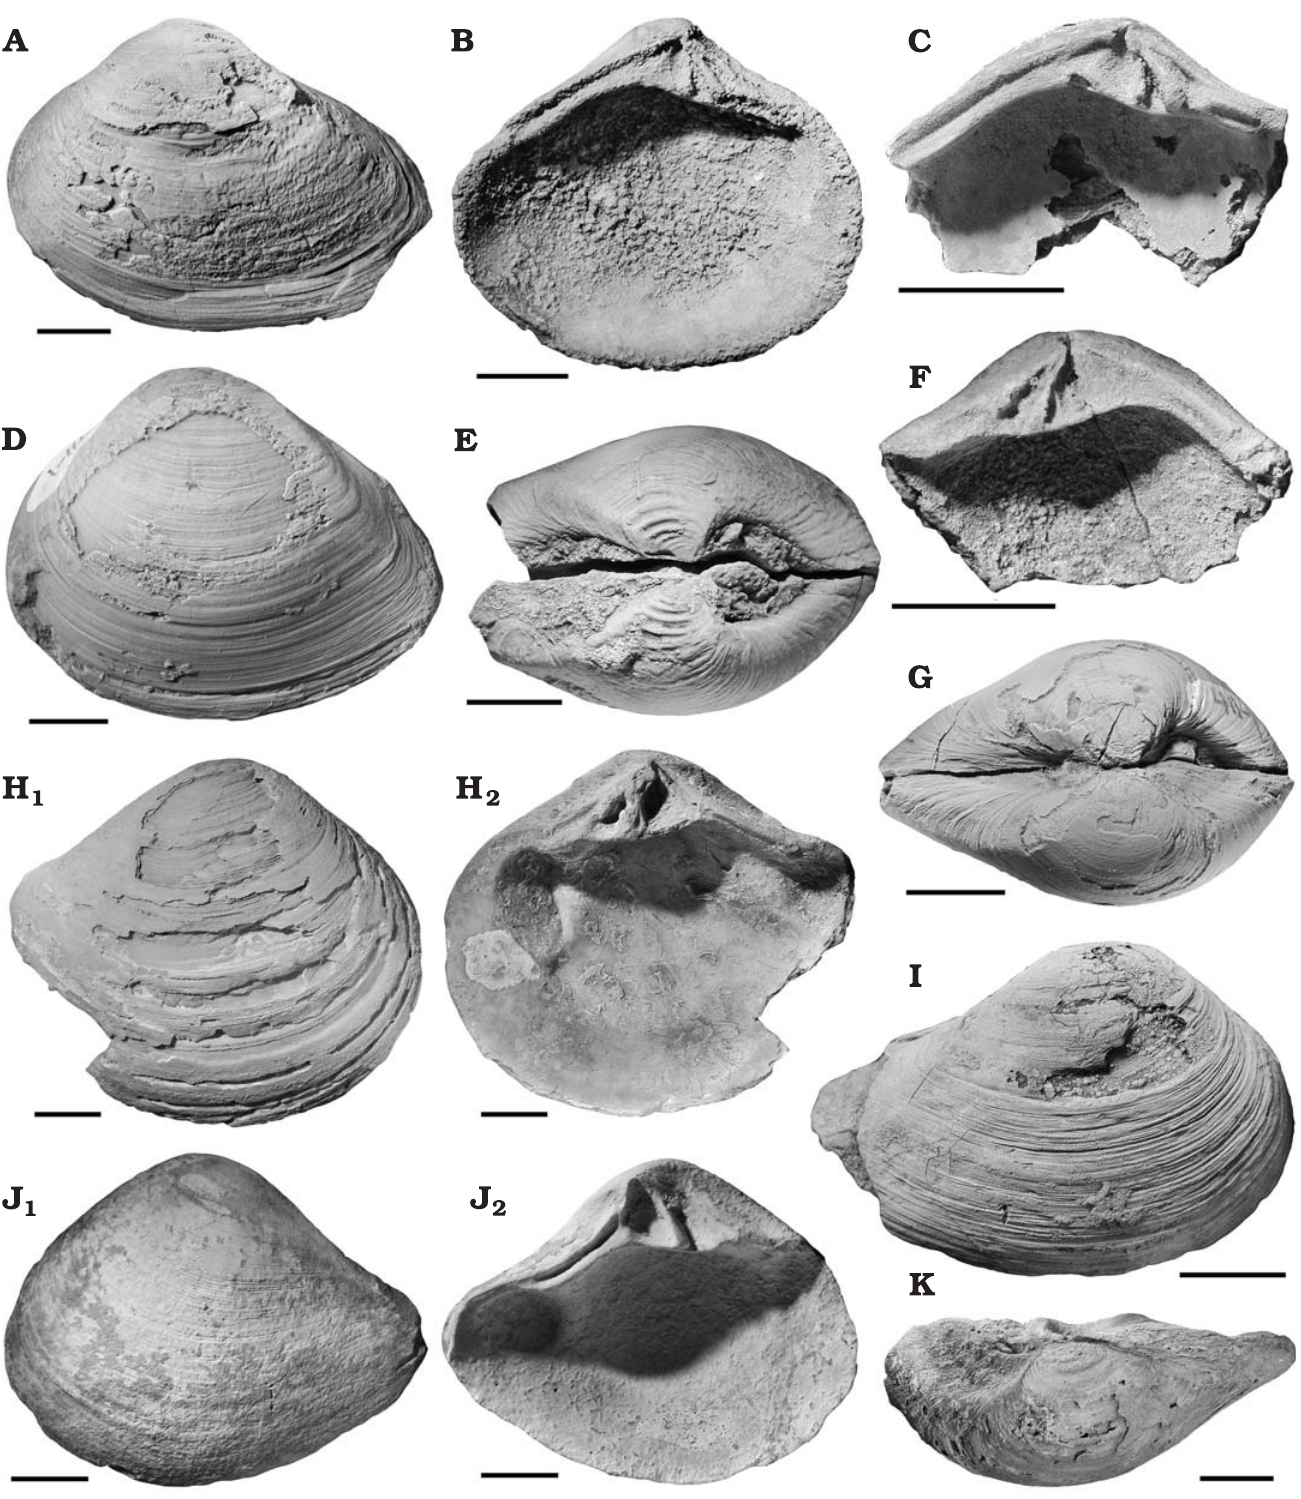
Fig. 10. Hybolophus crassatellines from Peru. A − G . Hybolophus maleficae sp. nov., middle Miocene, Pisco depositional sequence, south-central Peru. A . UWBM 101862, paratype, exterior of left valve. B . UWBM 101858, holotype, interior of left valve. C . UWBM 101860, paratype, interior of left valve. D . MUSM INV 222, paratype, exterior of left valve. E . UWBM 101864, dorsal margin of paired valves, anterior at right. F . UWBM 101859, paratype, interior of right valve. G . UWBM 101865, dorsal margin of paired valves, anterior at right. H , J , K . Hybolophus gibbosus (Sowerby, 1832), early to middle Pleistocene, tablazos, northern Peru. H . OSU 37600, exterior (H 1 ) and interior (H 2 ) of right valve. J . OSU 37597, exterior (J 1 ) and interior (J 2 ) of left valve. K . OSU 37601, dorsal margin of left valve, anterior at left. I . Hybolophus nelsoni (Grzybowski 1899), USNM 562398, late Miocene, Quebrada Heath, northern Peru; exterior of right valve. Scale bars 10